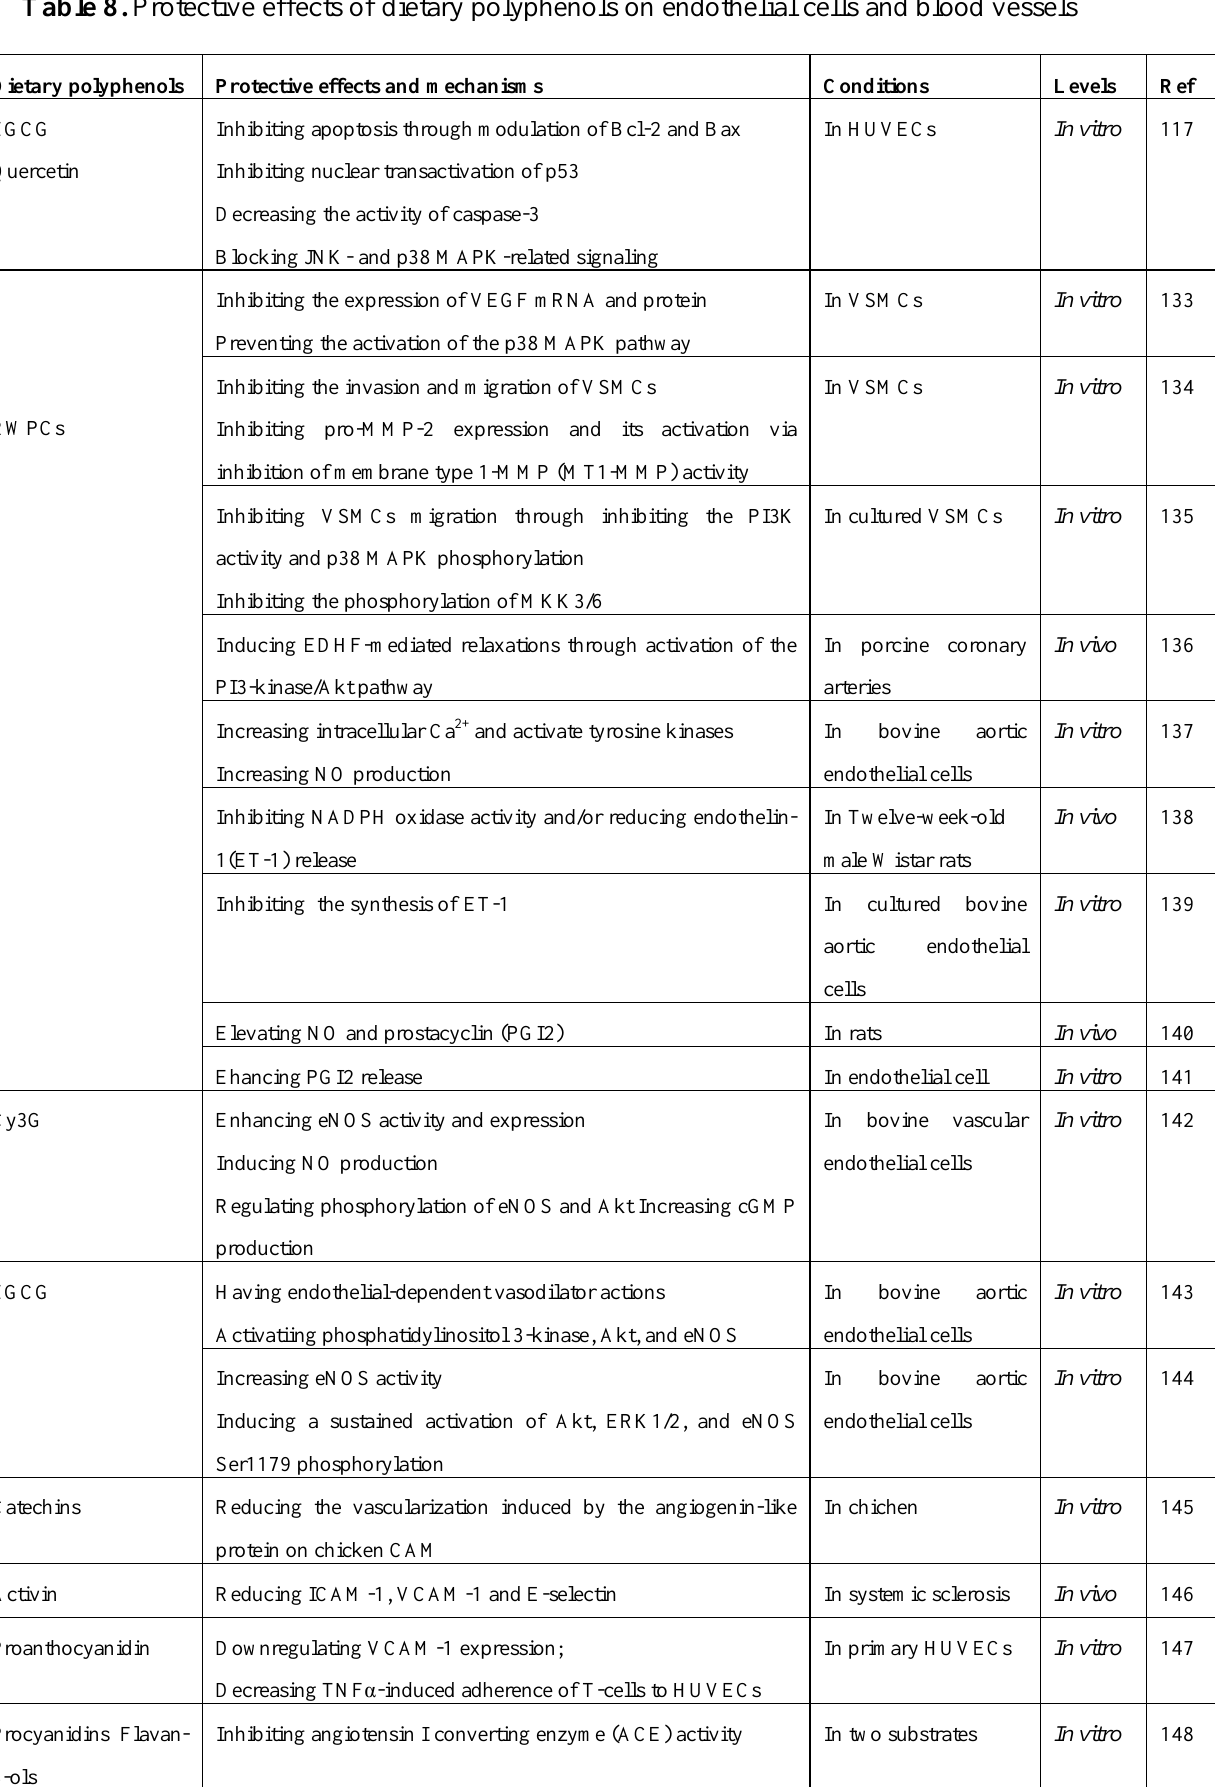
Table 8. Protective effects of dietary polyphenols on endothelial cells and blood vessels Dietary polyphenols Protective effects and mechanisms